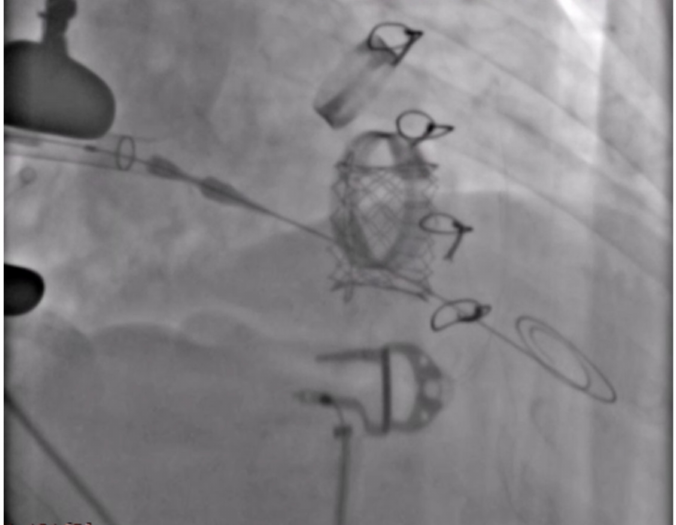
Figure 4. Fluoroscopic image showing the normofunctional Edwards Sapien 3 valve-in-valve after